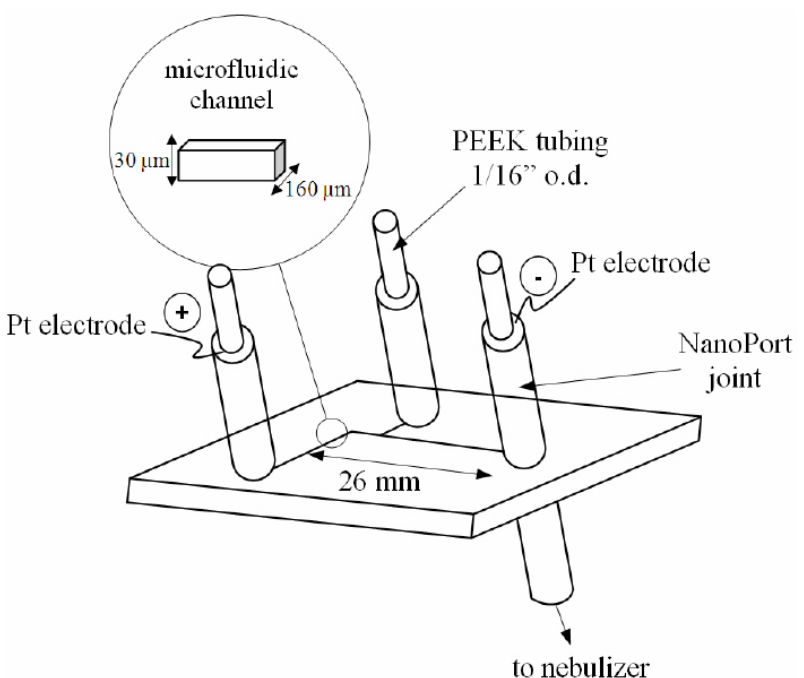
Figure 1. Schematic diagram of the microfluidic